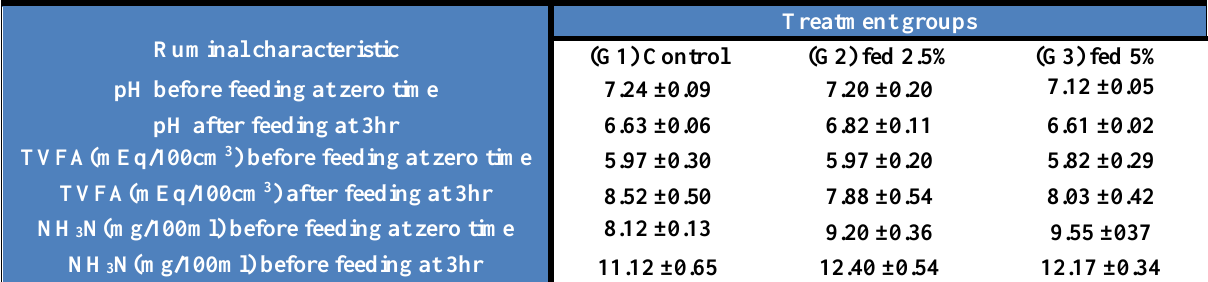
Table, 3: Effect of substitution of sunflower oil in the diet on the mean of ruminal fermentation characteristic of ewes (mean ±